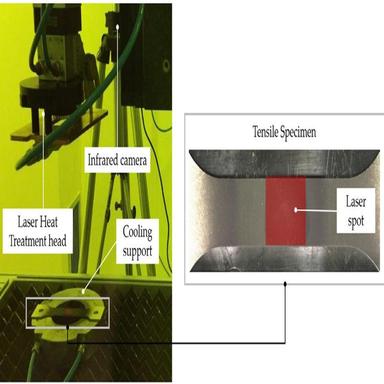
Experimental set up adopted for the Laser Heat treatments and geometry of the specimen.